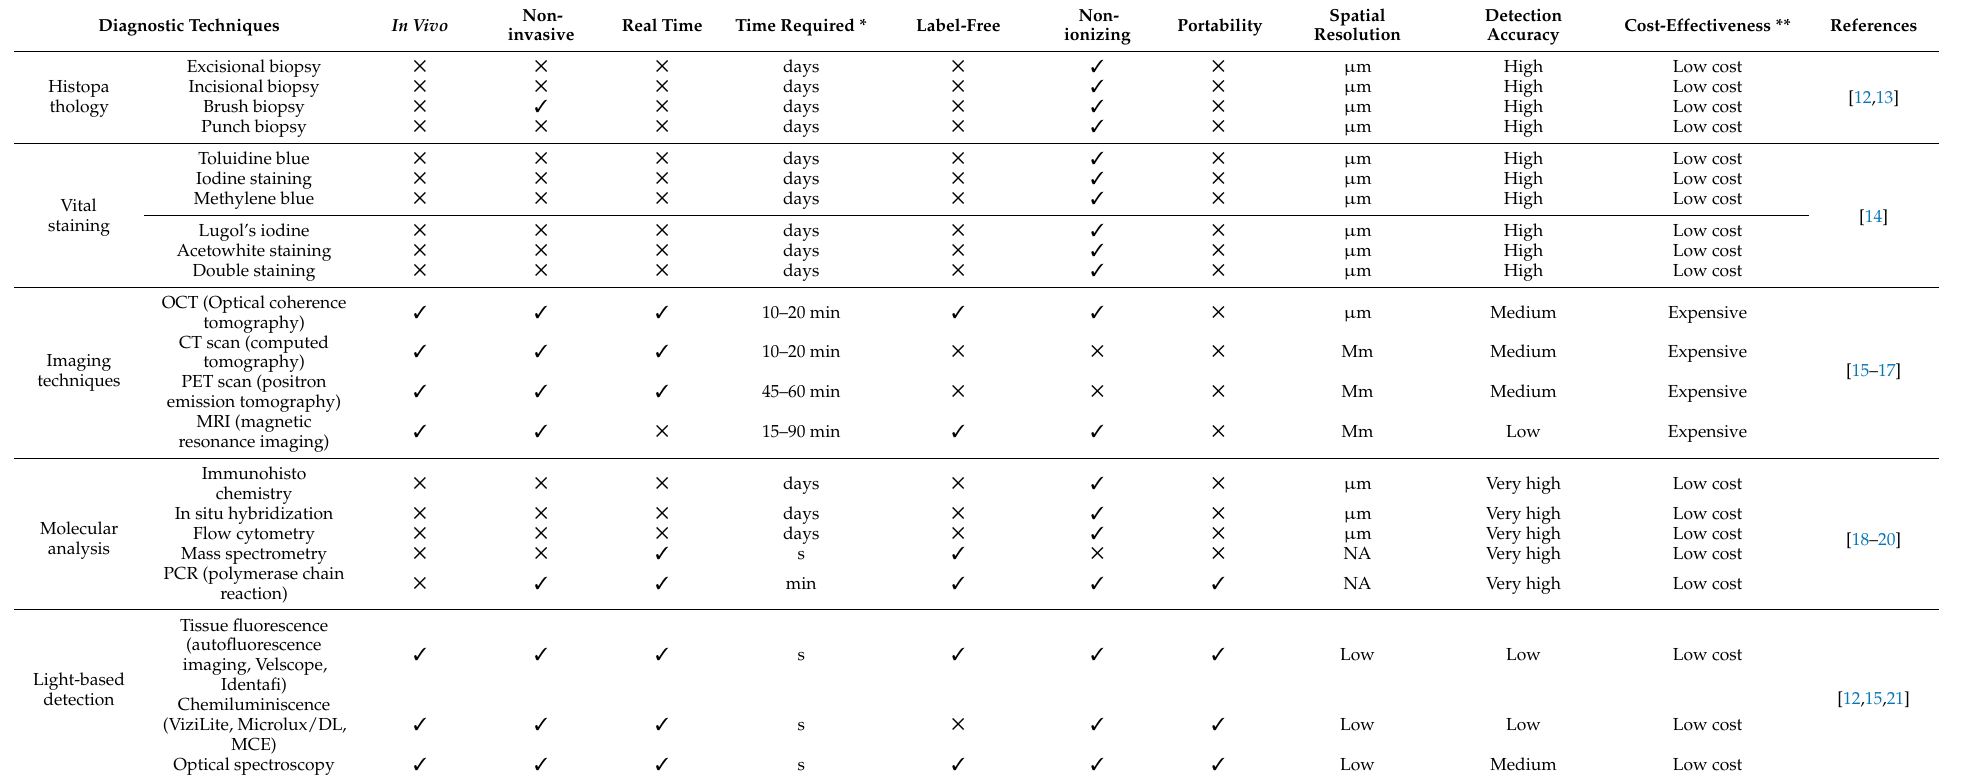
Table 1. Techniques for oral cancer diagnosis in addition to clinical oral